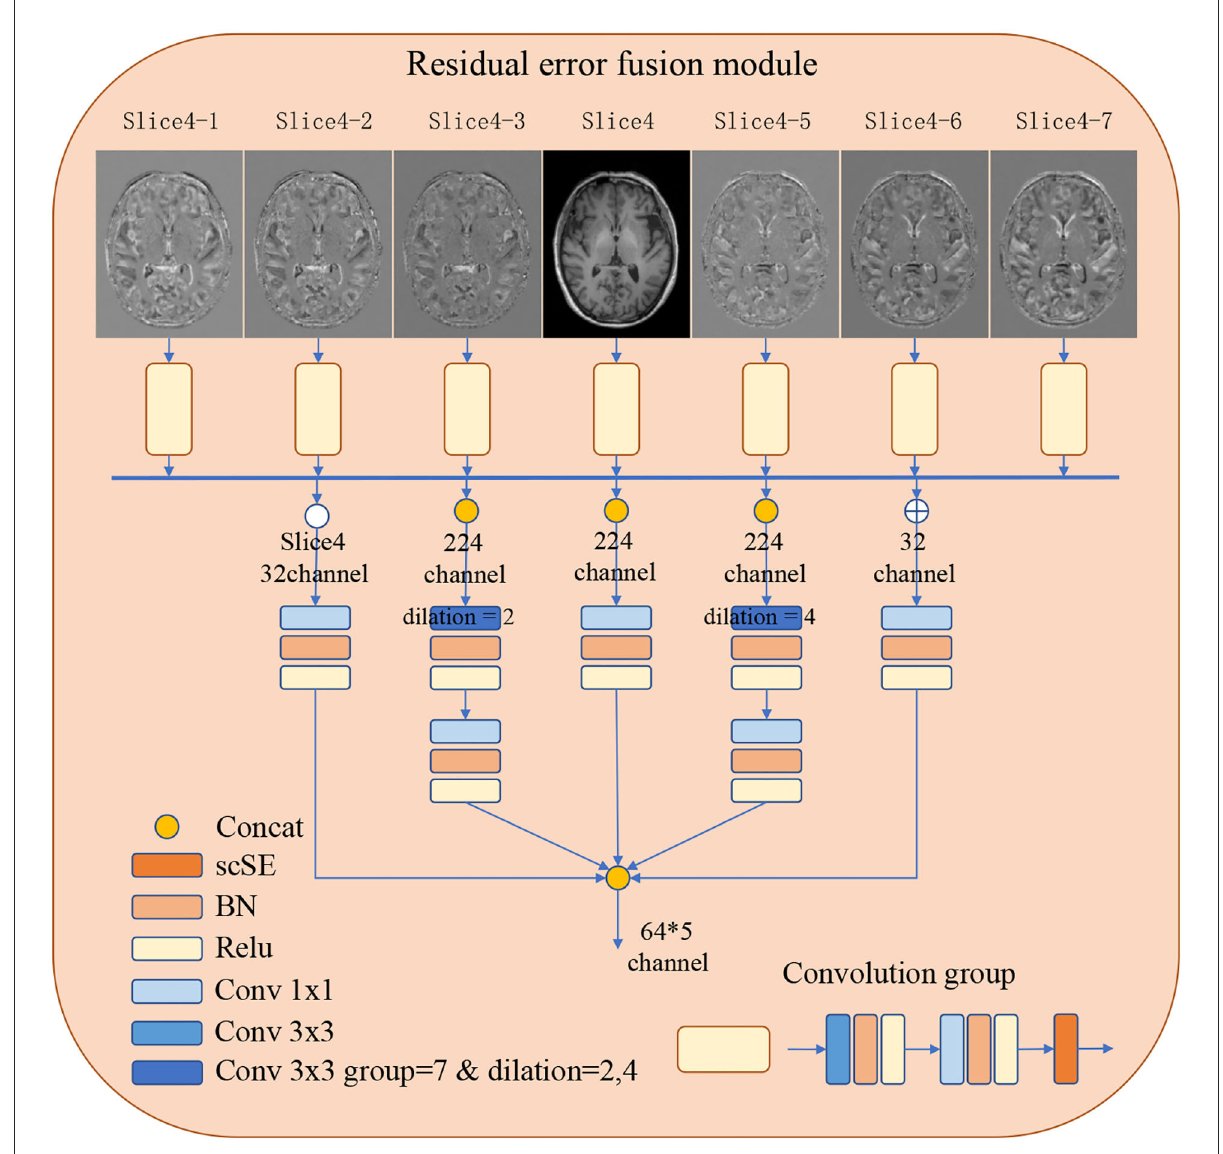
FIGURE2 The detailed architecture of the Residual error fusion module (REFM). Operations are shown in different colors, with a detailed description on the left side. The output of the module is further cascaded to the